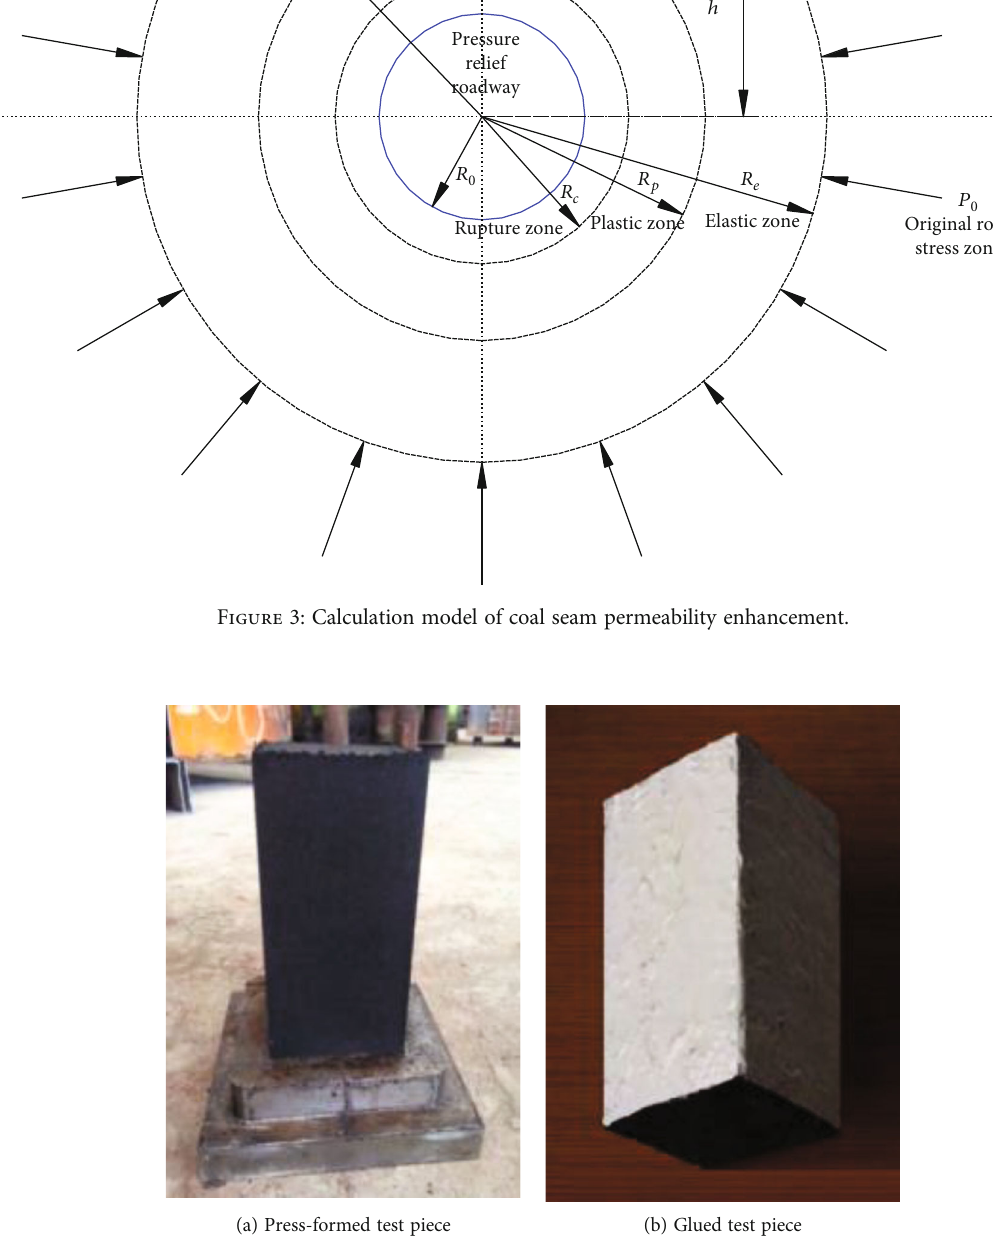
Figure 4: Physical image of rectangular coal briquette